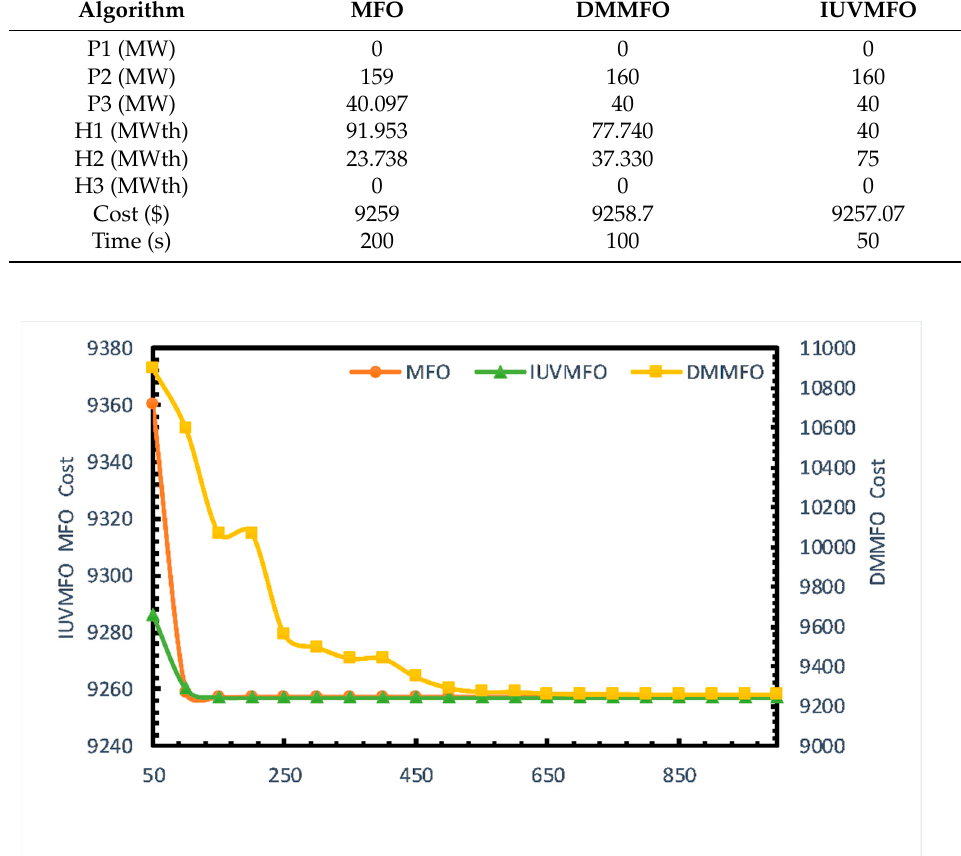
Figure 14. Curve diagram of algorithm test results.